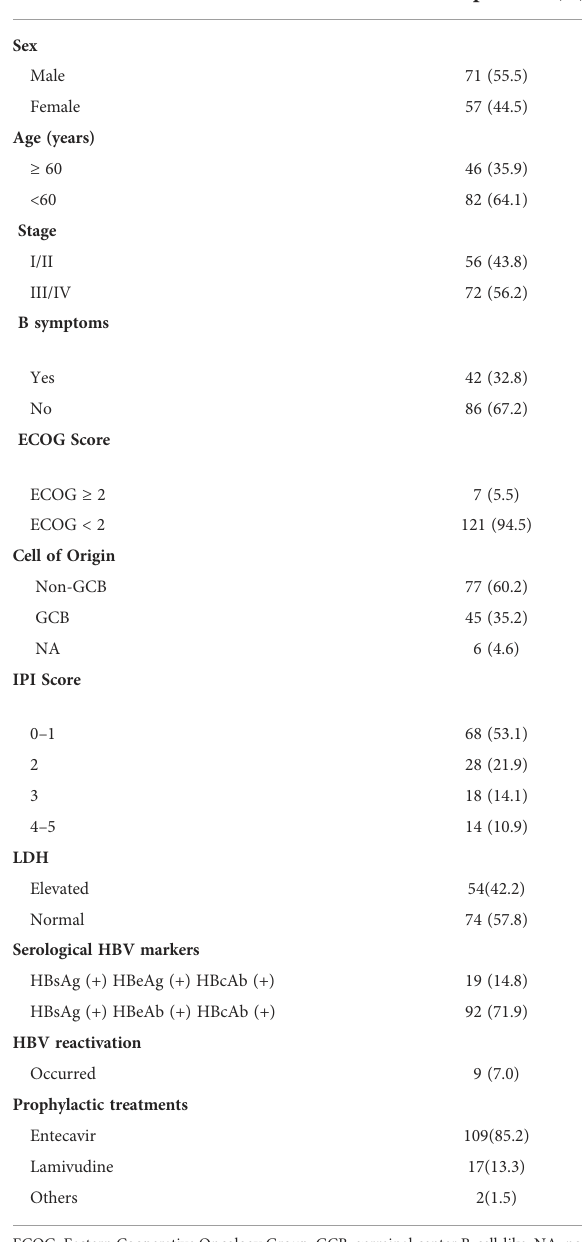
TABLE 1 Patients with hepatitis B virus surface antigen (HBsAg)- positive diffuse large B-cell lymphoma clinical characteristics (N =